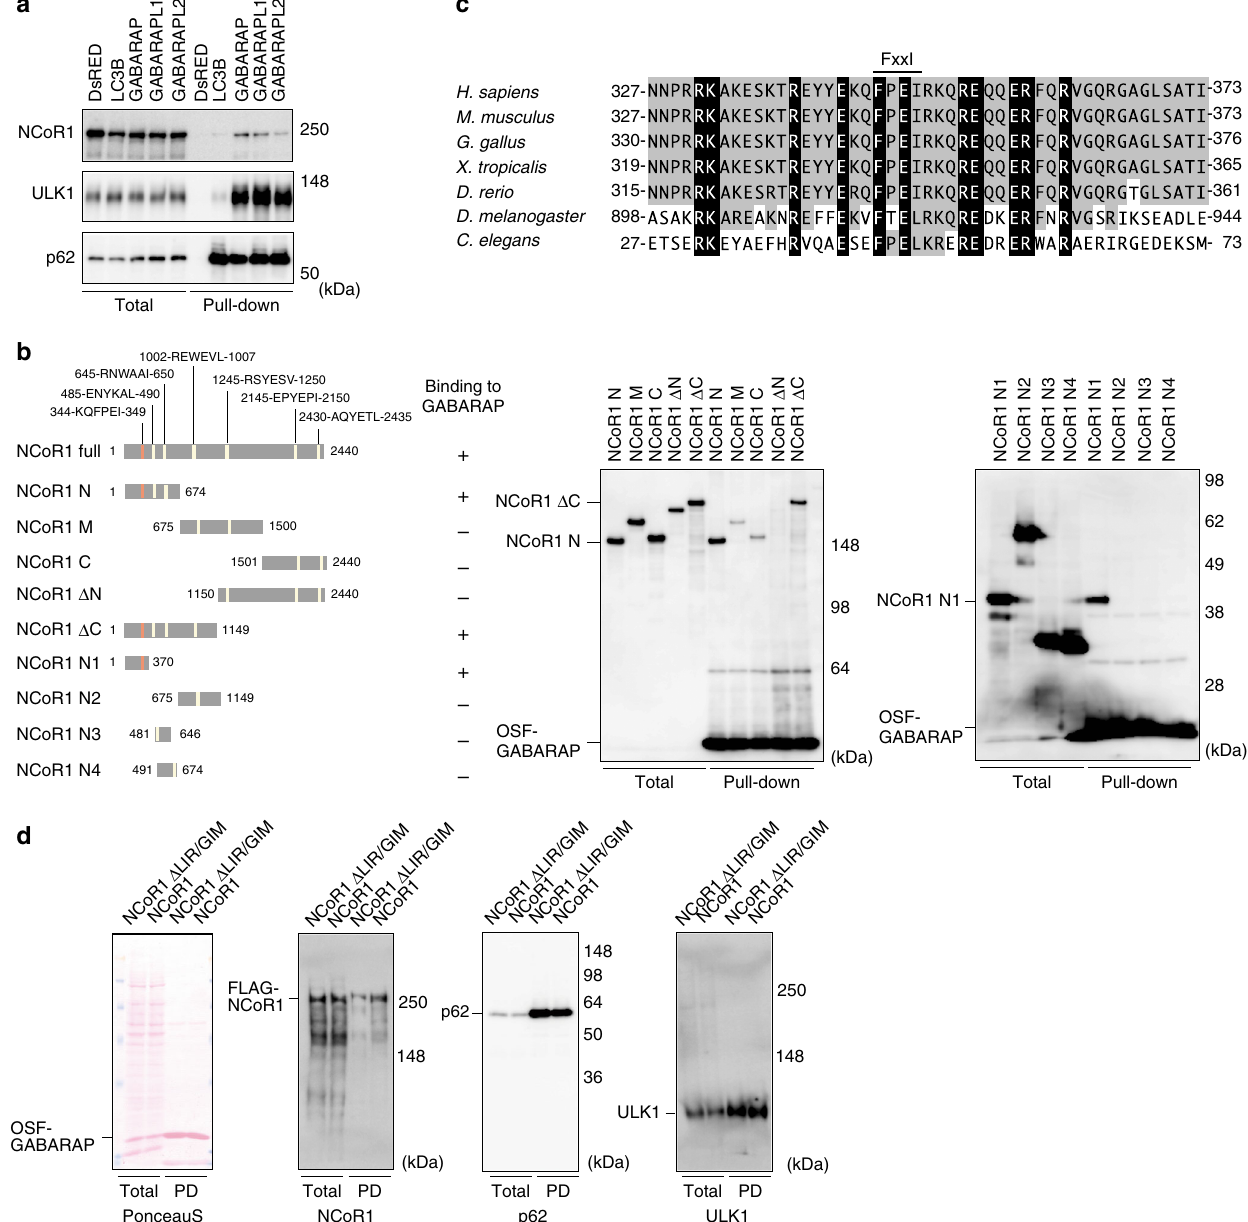
Fig. 8 Speci fi c interaction of NCoR1 with GABARAP. a Pull-down assay. One-Strep-FLAG (OSF)-tagged LC3B or GABARAP family proteins were expressed in HEK293T cells. Precipitates generated with Strep-Tactin Sepharose were subjected to immunoblot analysis with indicated antibodies. ULK1 and p62 bind to GABARAP family and all Atg8 family proteins, respectively, and were therefore used as positive controls. Data are representative of three independent experiments. b Diagrams of the deletion-mutation constructs of NCoR1 (left panel) and the corresponding pull-down assays (middle and right panels). Middle panel: Each FLAG-tagged NCoR1-deletion mutant and OSF-GABARAP was co-expressed in HEK293T cells. At 48 h post-transfection, lysates were prepared and precipitated with Strep-Tactin Sepharose. Right panel: OSF-GABARAP immobilized on Strep-Tactin Sepharose was mixed with lysates prepared from cells expressing each NCoR1-deletion mutant. The resultant precipitates were subjected to immunoblotting with anti-FLAG antibody. Data are representative of three independent experiments. c Alignment of the LC3-interacting region (LIR)/GABARAP-interacting motif (GIM) of NCoR1 homologs in various species. Black and gray boxes indicate identical amino-acid residues with complete and partial conservation, respectively. d Pull-down assay. OSF-GABARAP and FLAG-NCoR1 or NCoR1 Δ LIR/GIM were co-expressed in HEK293T cells. The assay was carried out as described in